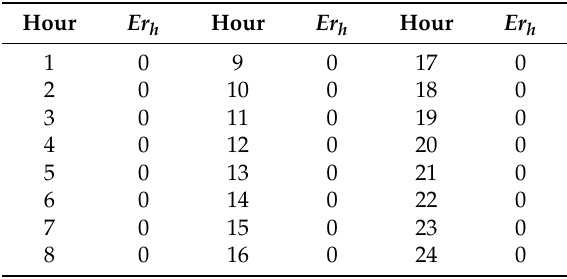
Table 4. Running results of Algorithm